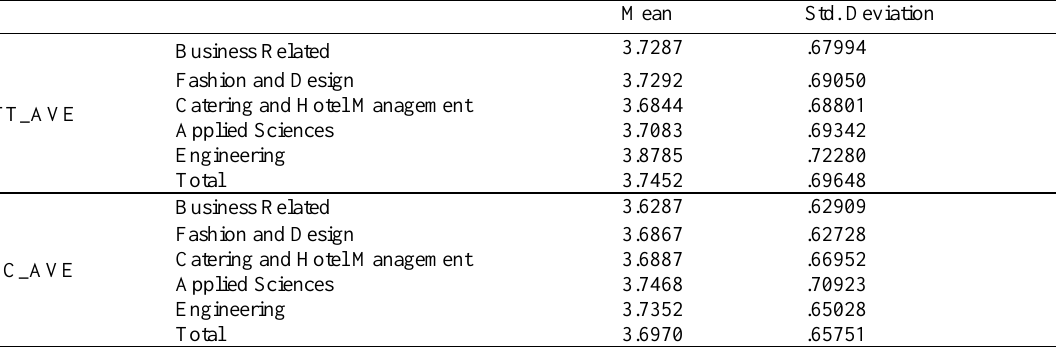
Table 12: Statistics on student and Graduate IEC due to Programme studied in School Mean Std.